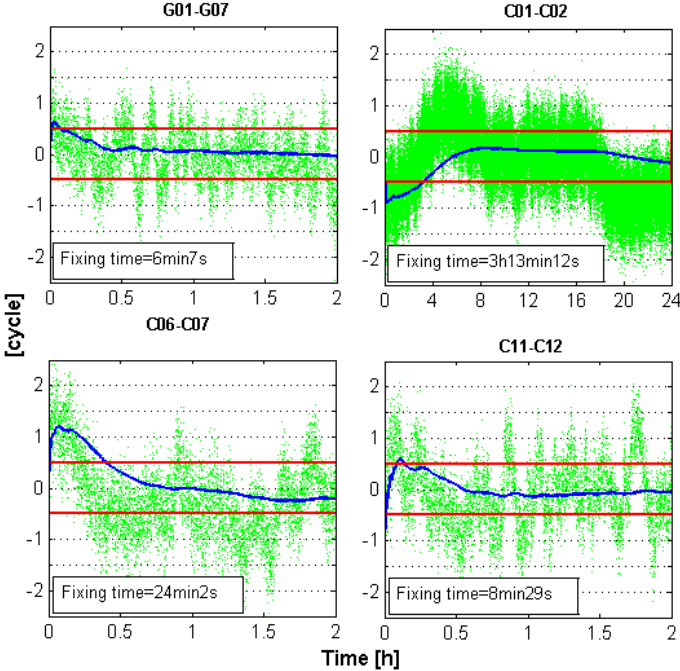
Figure 5. Averaged values of the HMW combination for baseline WHCD-WHHP. The red lines indicate the threshold of rounding. Green dots indicate the single-epoch values of the HMW combination. Blue lines indicate the averaged value of the HMW combination. Table 9. Minimum time needed for reaching 100% fixing rate. The results of the WL combination are computed based on the HMW combination. The results of the EWL-I and EWL-II combinations are computed based on Equations (3) and (5), respectively.